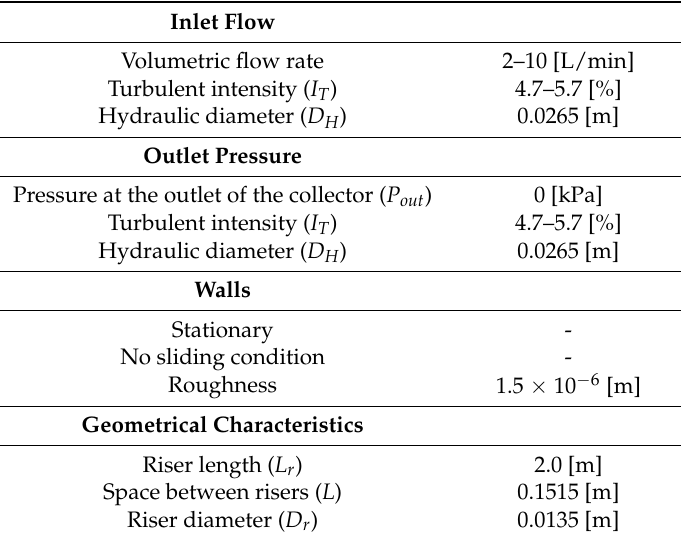
Figure 3. Sketch of the flat plate solar collector. Table 3. Boundary